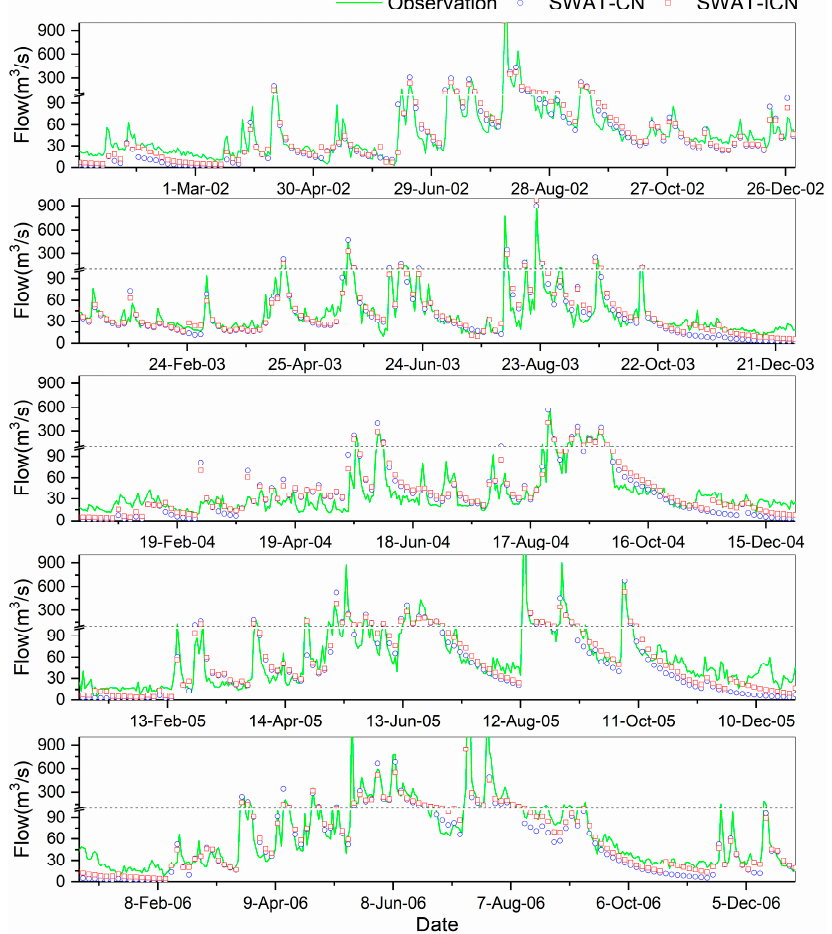
Figure 4. Simulated and observed hydrographs for the calibration period.